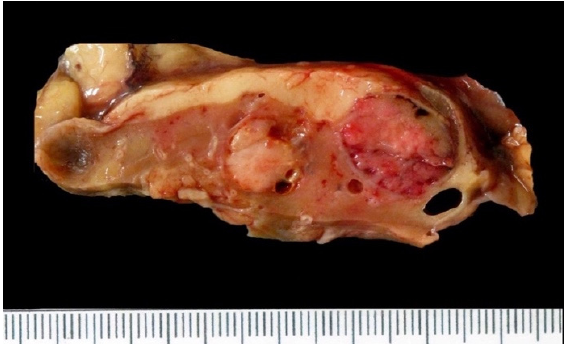
Figure 2. Concurrent ACKD-RCC and ccpRCC in a single kidney. Two tumors occurred simultane- ously in this nephrectomy, a ccpRCC (right side of picture, abutting renal capsule) and a smaller ACKD-RCC (central part of picture).